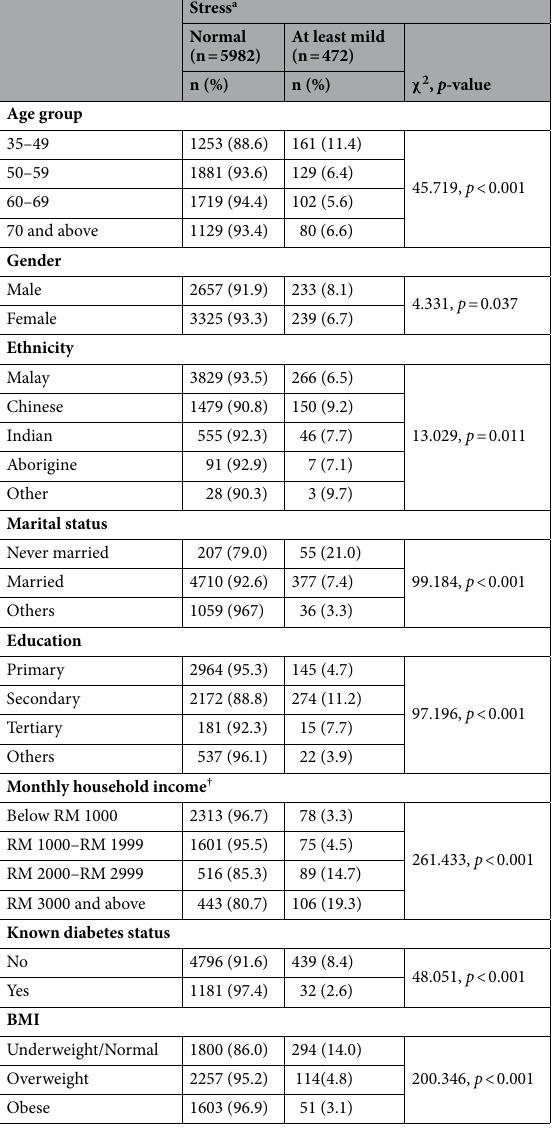
Table 4. Socio-demographics and diabetes status by stress. BMI, Body Mass Index. Values in parentheses are the percentage of the cases. † USD1 is equivalent to RM 3.00 (13th May 2013). a The total number of respondents answered the assessment of stress was